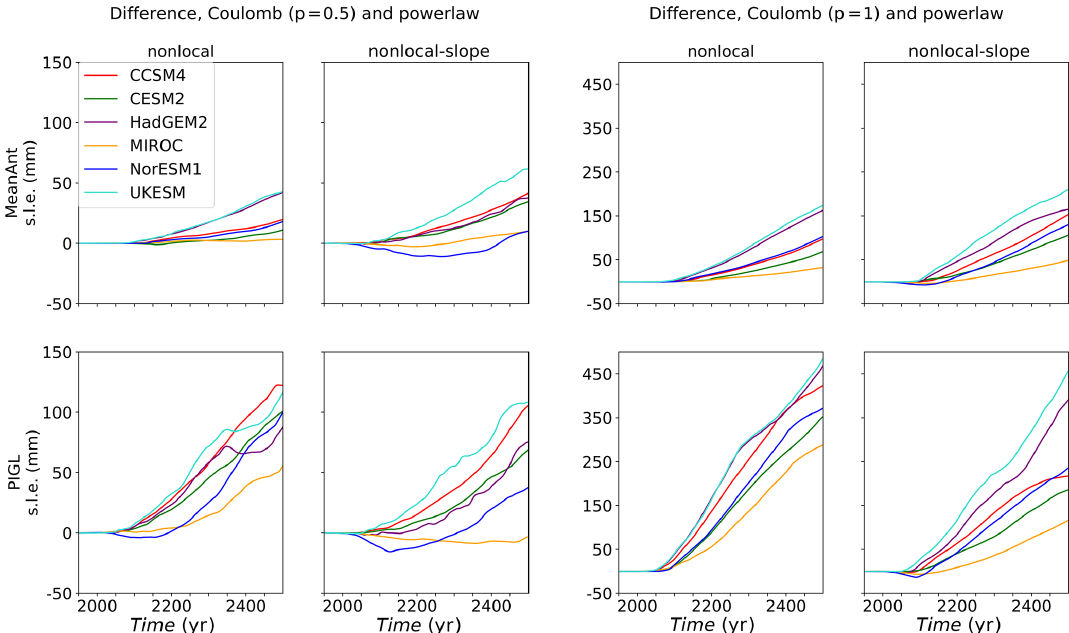
Figure 19. Difference in SLR contribution (mms.l.e.) during 550-year projection experiments, comparing runs with power-law friction and Coulomb friction near the grounding line. The four left-hand panels show the difference between Coulomb friction with p = 0 . 5 and power- law friction, and the four right-hand panels show the difference between Coulomb friction with p = 1 and power-law friction. The four panels at each resolution correspond to the nonlocal and nonlocal-slope melt parameterizations with the MeanAnt and PIGL calibrations. Note the different vertical scales in the left and right panels.